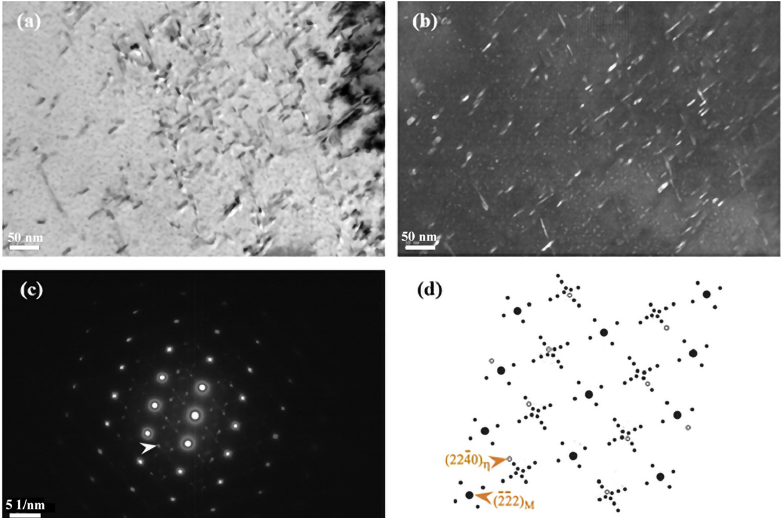
Figure 2. TEM photo of 00Cr12Ni10MoTi maraging stainless steel aged at 510 °C for 4 h: ( a ) bright-field image, ( b ) dark-field image taken from the diffraction spot indicated by an arrow in ( c ) showing precipitates, ( c ) selected area diffraction pattern with zone axis [ 011 ] α (cid:48) , ( d ) schematics of selected area diffraction pattern with zone axis [ 011 ] α (cid:48) .